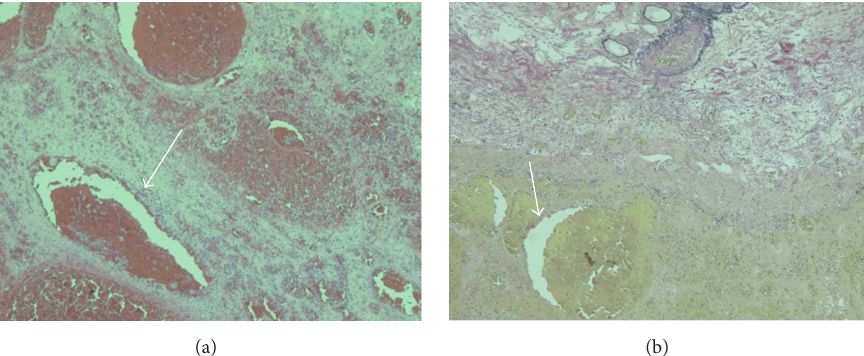
Figure 4: (a) Pathological finding showing an extended vessel in the submucosa of the sigmoid colon (arrow). (b) There was no elastic fiber in an extended vessel